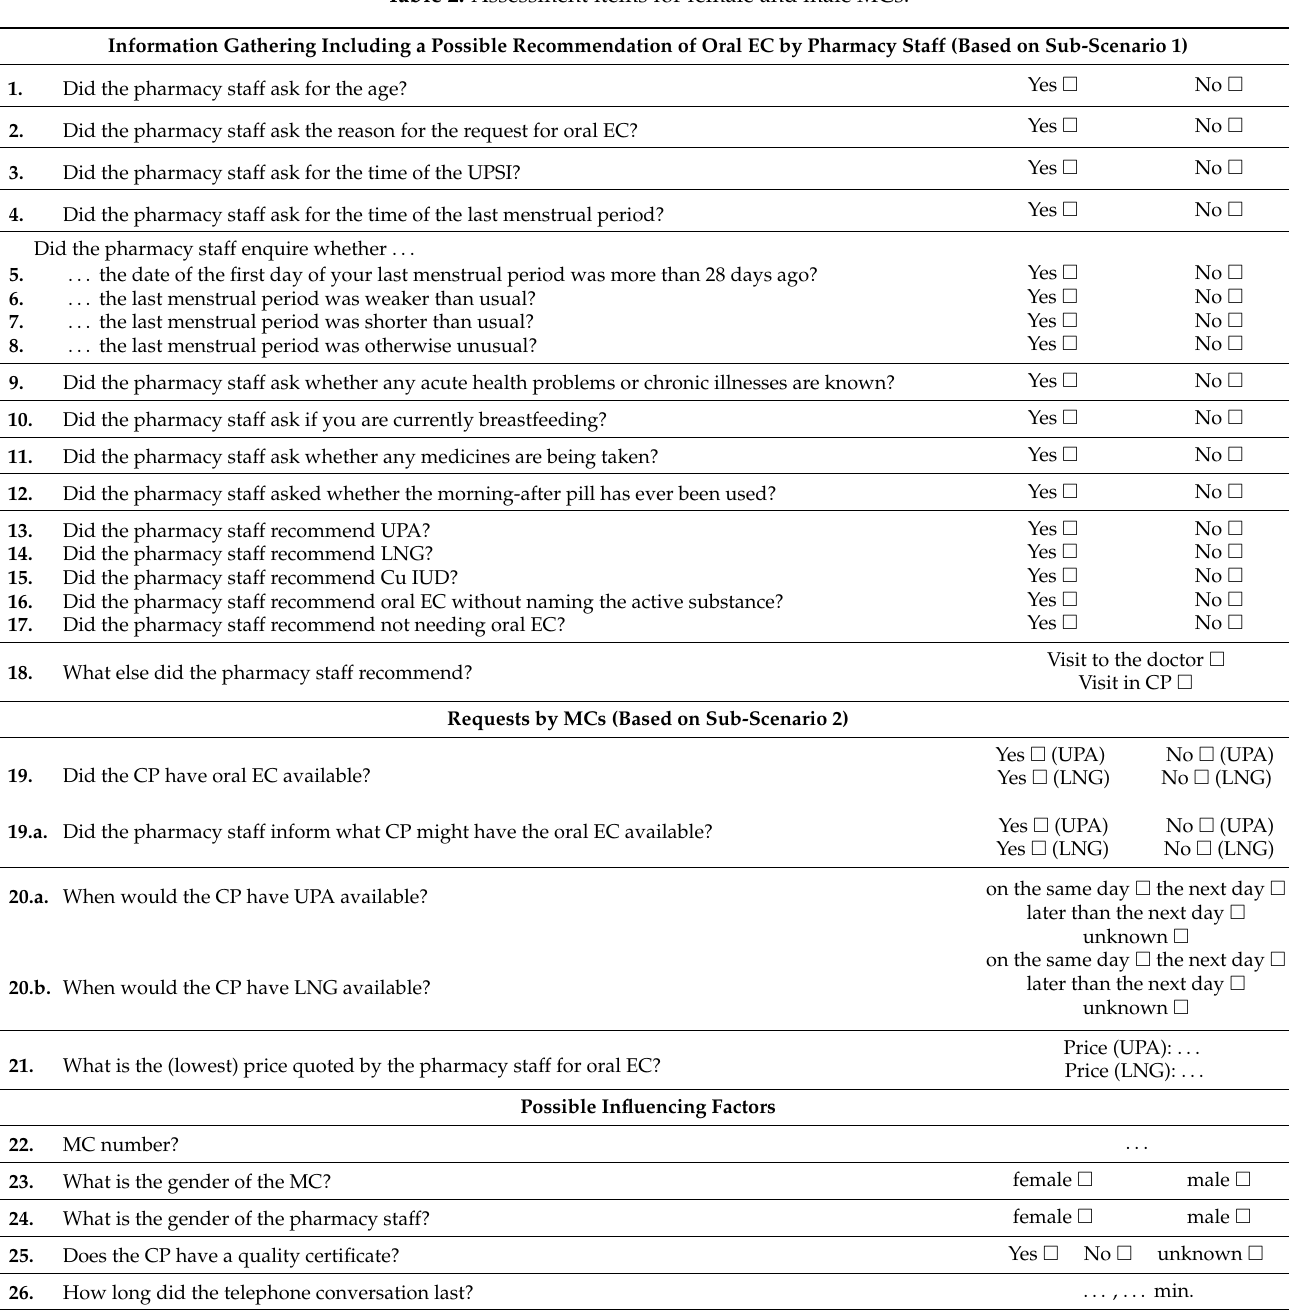
Table 2. Assessment items for female and male